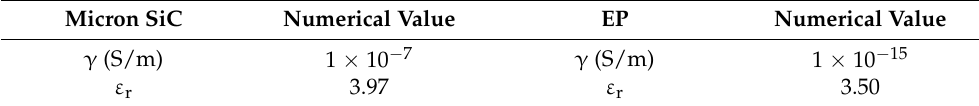
Table 4. Material property setting of micron composite model.